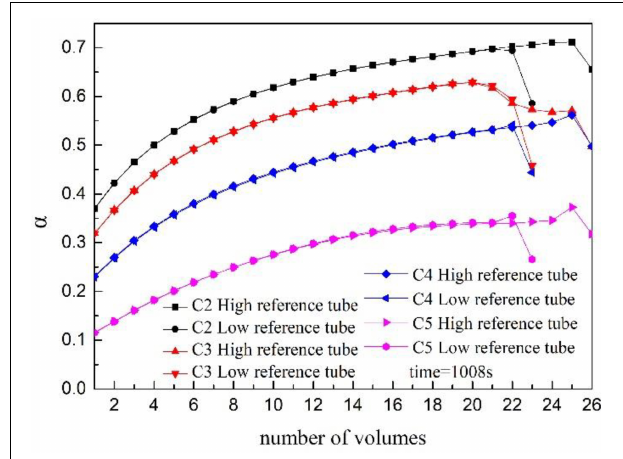
FIGURE 8 | Void fraction of different reference tube volume.